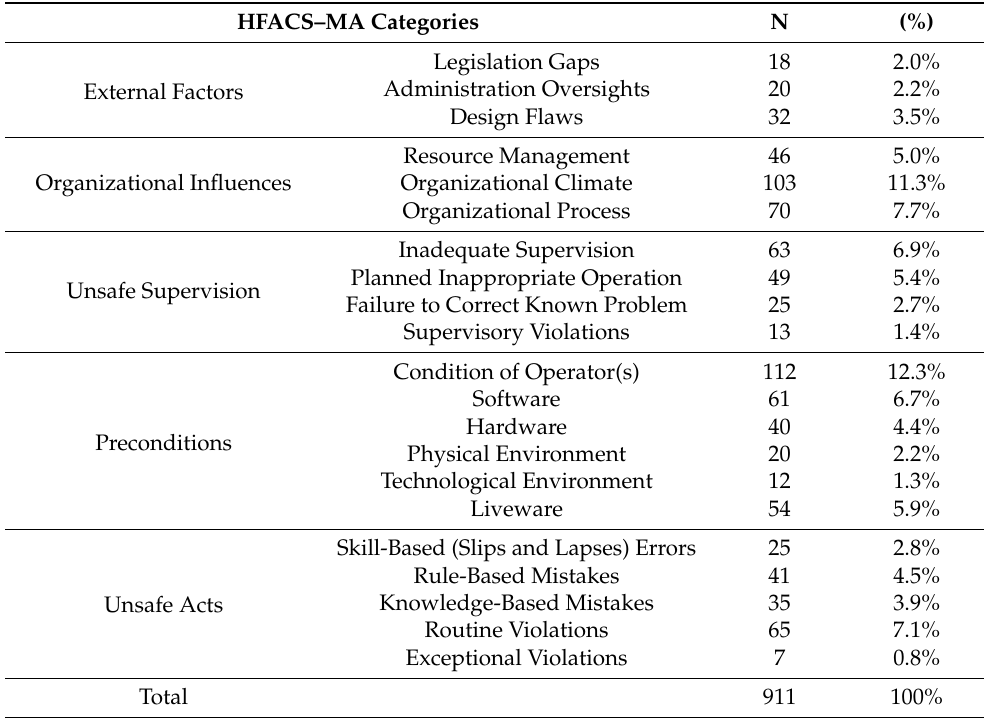
Table 2. Distribution of obtained HFACS-MA causal factor